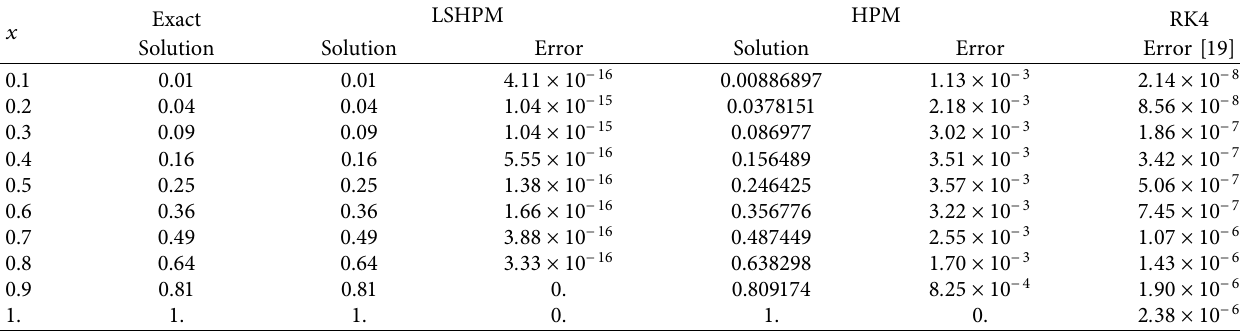
Table 2: Comparison of second-order absolute error of LSHPM with HPM and RK4 in Problem 2.